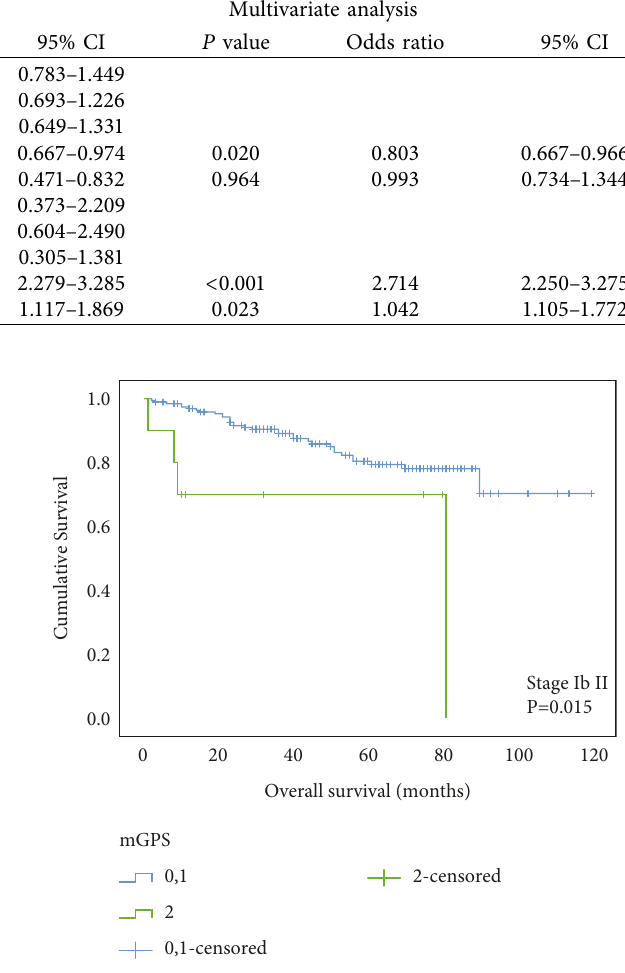
Figure 1: Relationship between the mGPS and overall survival in patients with gastric cancer.